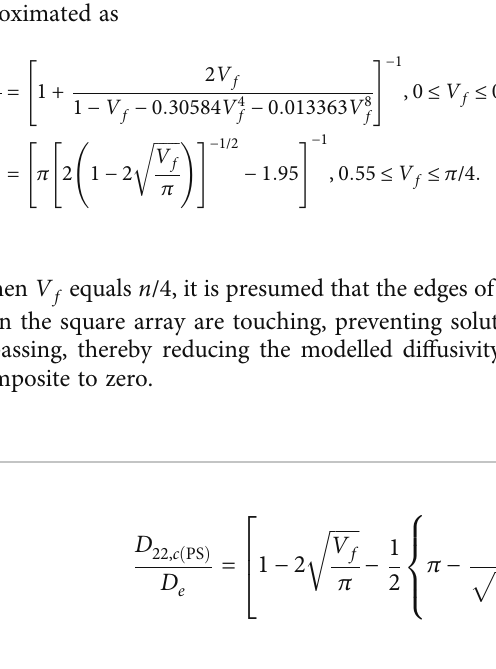
/ π V f ffiffiffiffiffiffiffiffiffiffi / V f